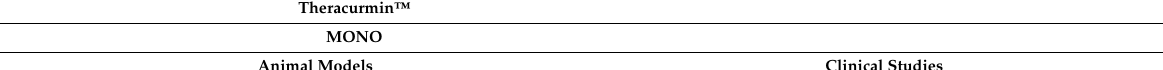
Table 6. E ff ects of Theracurmin ™ obtained in vitro, in vivo and in clinical